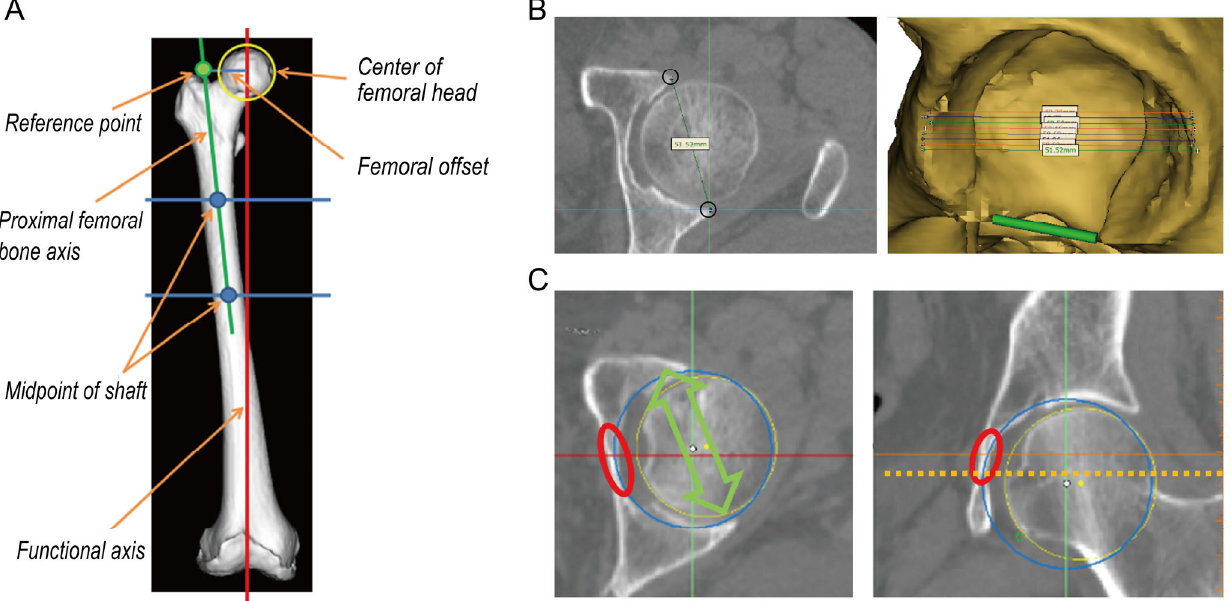
Figure 2. ( A ) Three ‐ dimensional femoral bone model; ( B ) Left: axial slice of the maximum distance of the outer edge of the acetabulum; Right: three ‐ dimensional acetabular bone model; ( C ) a blue